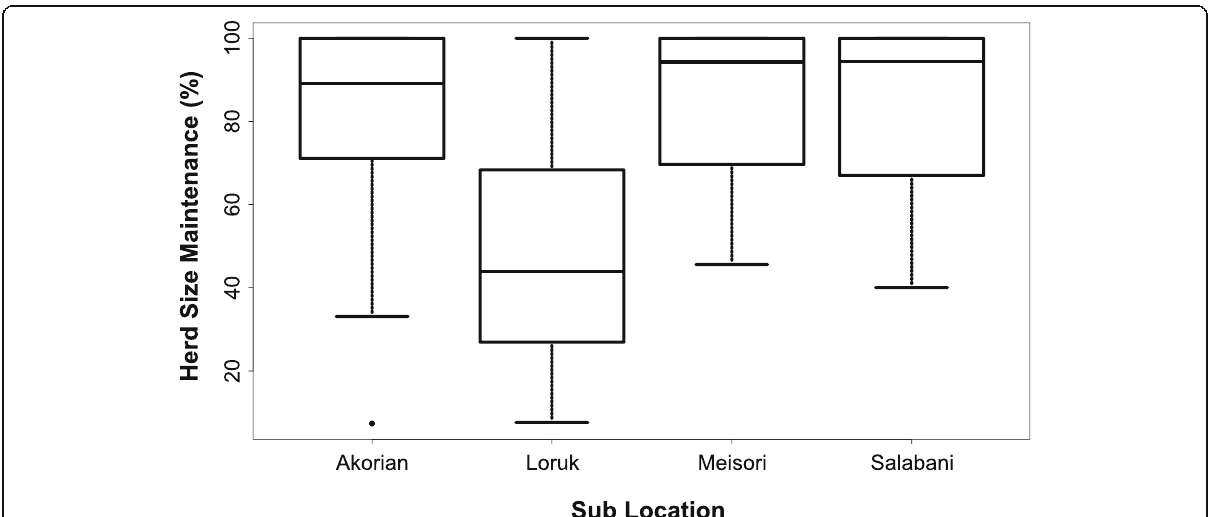
Fig. 2 Herd size maintenance percentages. Note: Figures obtained through comparing herd size from before and after the 2019 drought for the agro-pastoralists from the four sub-locations near Lake Baringo,